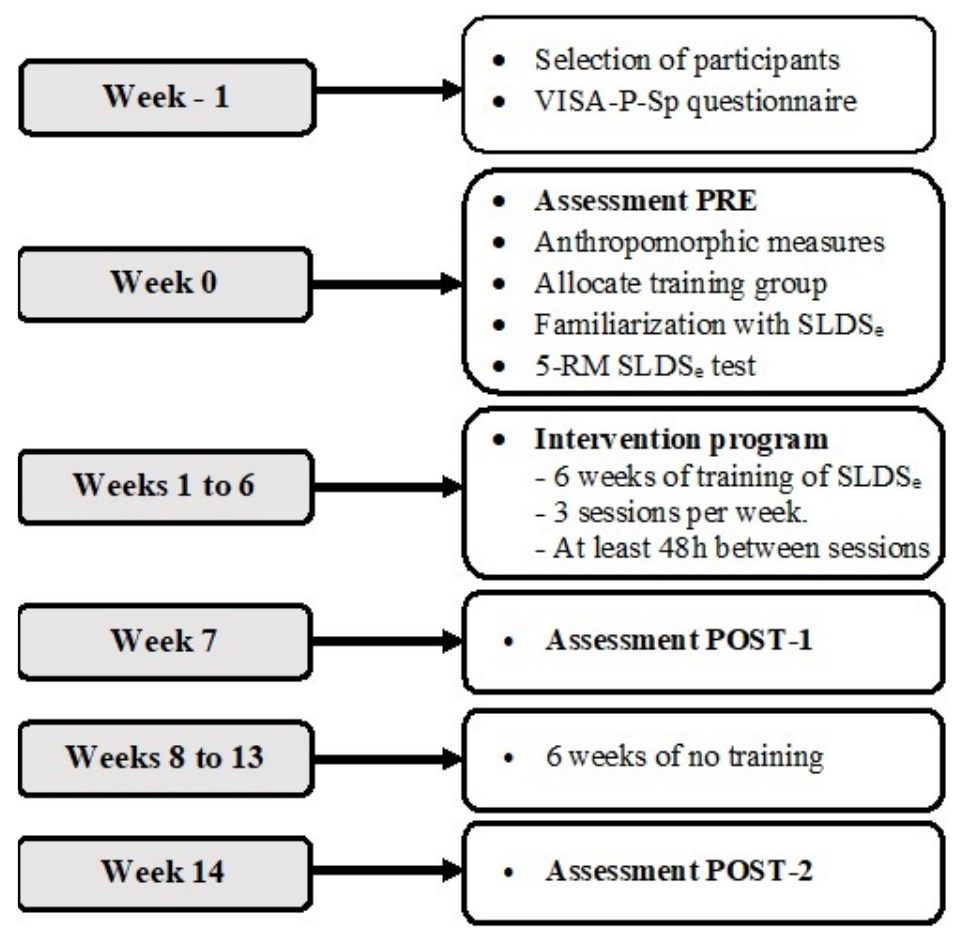
Figure 2. Design of the investigation.